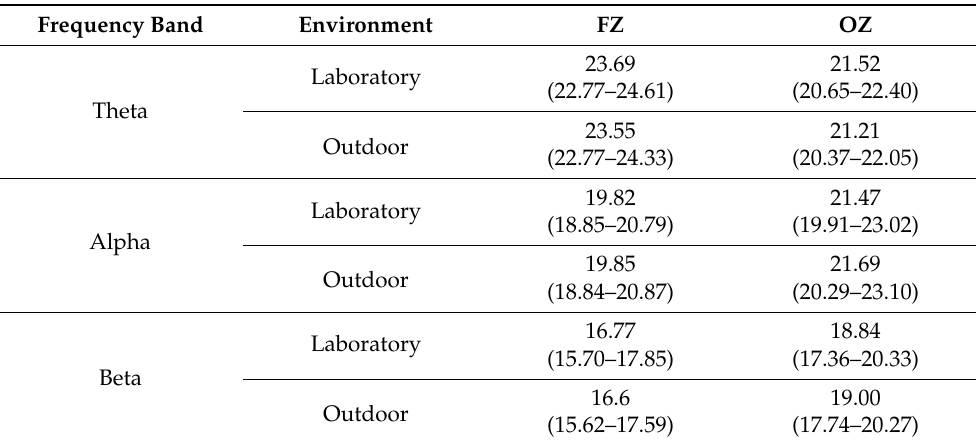
Figure 4. EEG spectral power (in decibels) at ( a ) frontal site FZ and ( b ) posterior site OZ for PASAT (solid lines), and eyes open resting states (dashed lines) for comparison, in the laboratory (black lines) and outdoor (red lines) environments. Table 4. Mean PASAT EEG